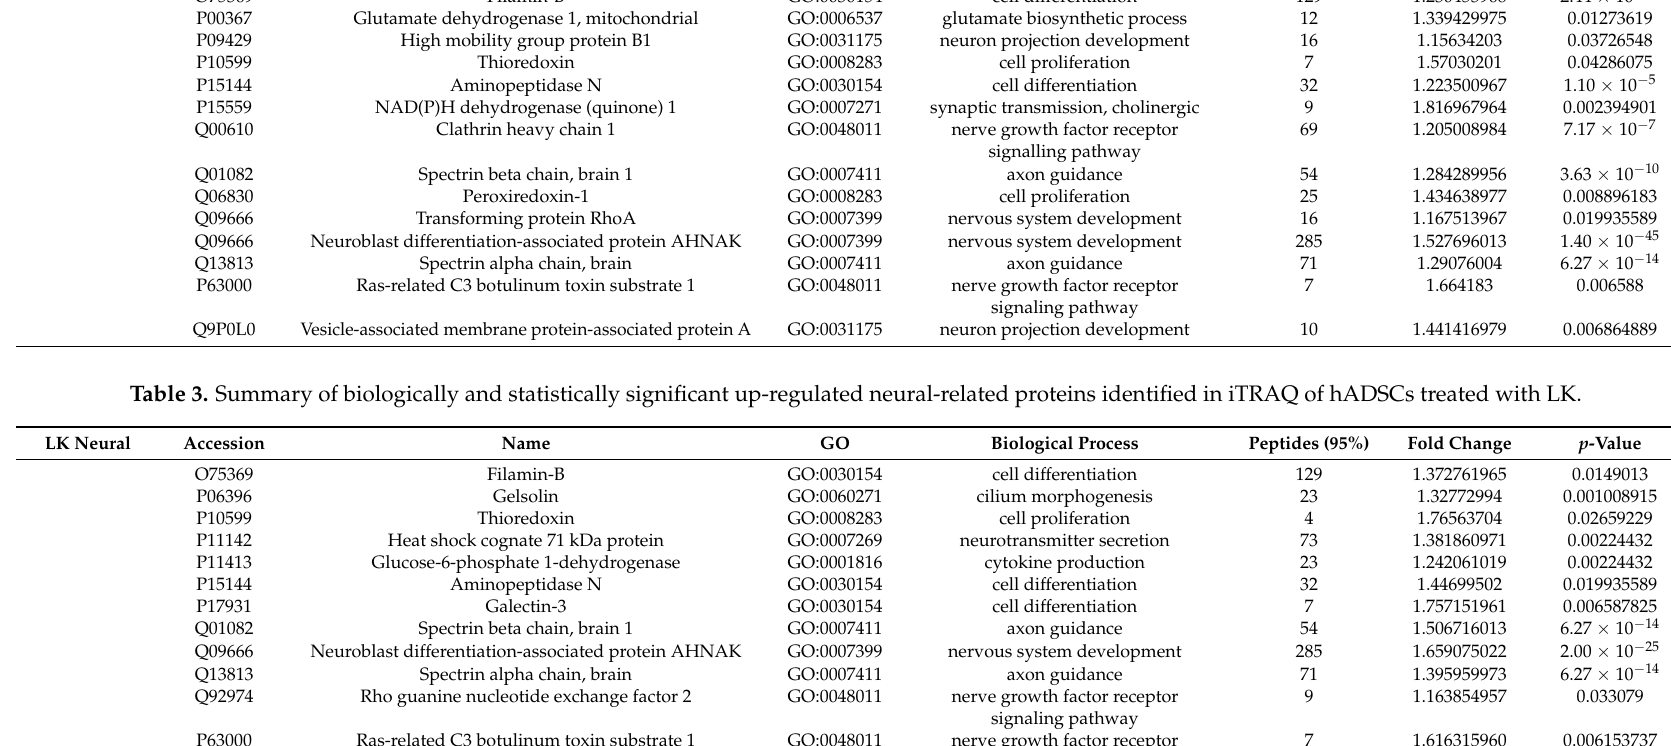
Table 2. Summary of biologically and statistically significant up-regulated neural-related proteins identified in iTRAQ of hADSCs treated with AECK. AECK Neural